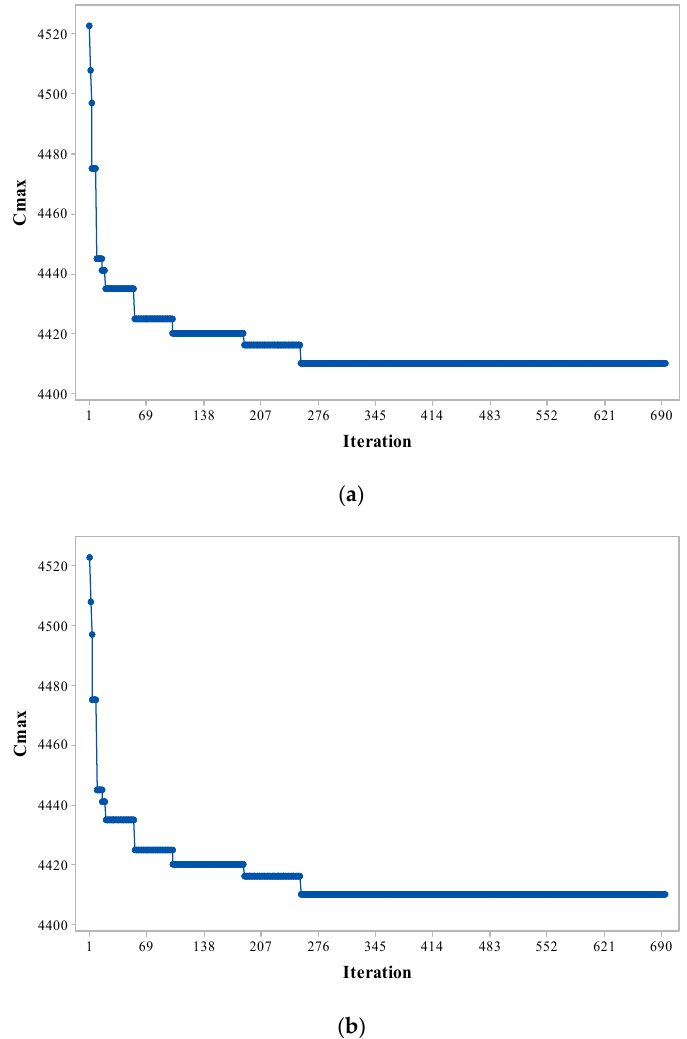
Figure 5. Convergence analysis for different instances when ρ = 10. ( a ) The instance with 20 casts and 61charges; ( b ) The instance with 40 casts and 114 charges.